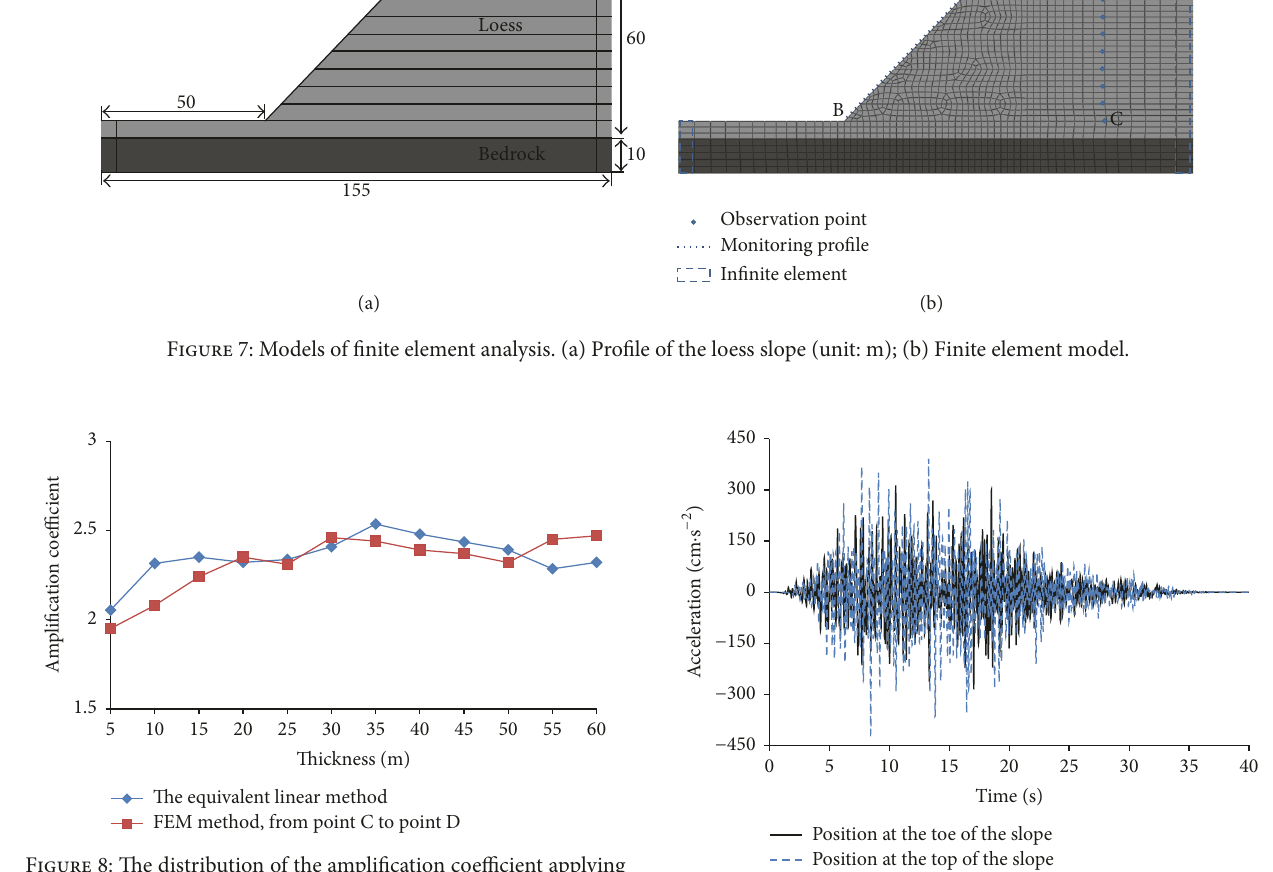
Figure 9: The comparison of acceleration time histories at different positions.